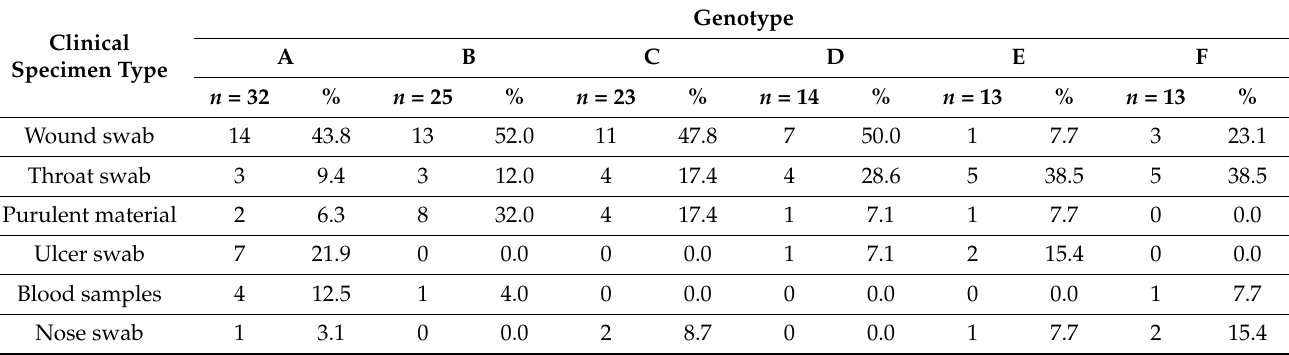
Table 3. The distribution of genotypes A–F with respect to origin of S. pyogenes strains from selected types of clinical material.